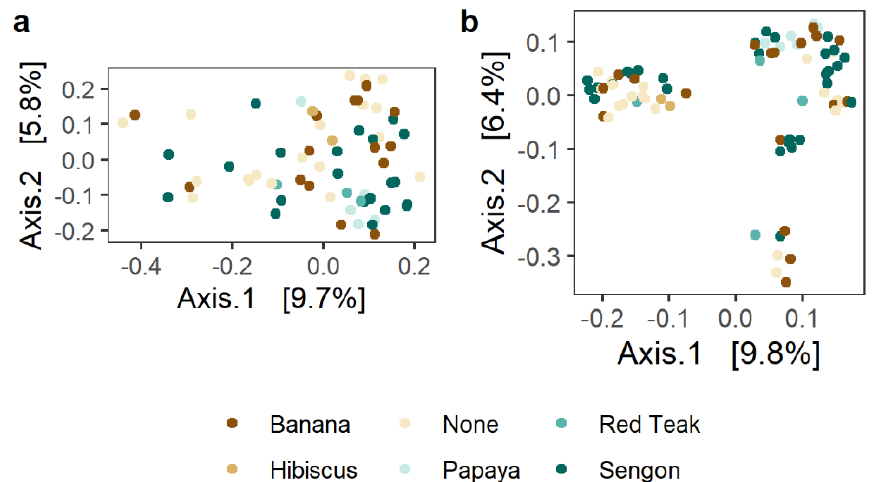
Figure 3. Principal coordinates analysis (PCoA) based on Bray–Curtis distance of bacterial and fungal communities. No effect of shade tree presence or species identity was observed for either ( a ) bacteria or ( b ) fungi (both ANOSIM p > 0.05). Points represent cacao rhizosphere microbial communities, and colors indicate the species of the nearest shade tree.